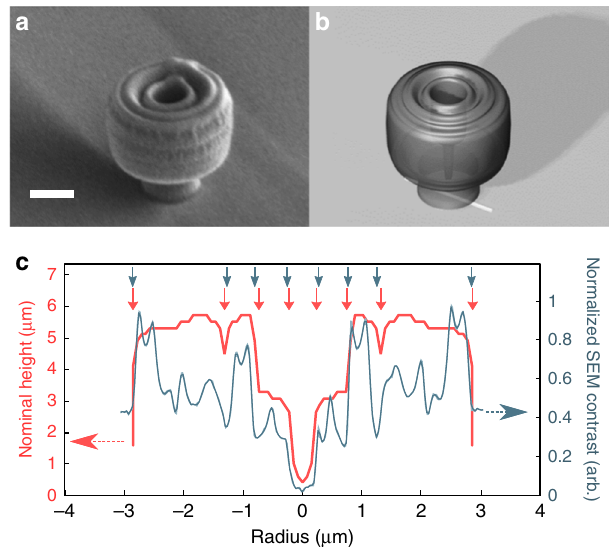
Fig. 3 Fabricated nanophotonic lens. a SEM image of a nanophotonic lens structure printed over an embedded nanowire (not visible), and compared with, b computer 3D rendering of the as-designed structure, at the same imaging conditions. Scale bar = 2 μ m. c Plot of the observed contrast in a top-view SEM image compared with the height pro fi le of the as-designed structure, showing agreement between observed and designed features (indicated by the vertical arrows, at the onset of the step change in the data); the small shaded region is the standard deviation in SEM contrast, averaged over 10